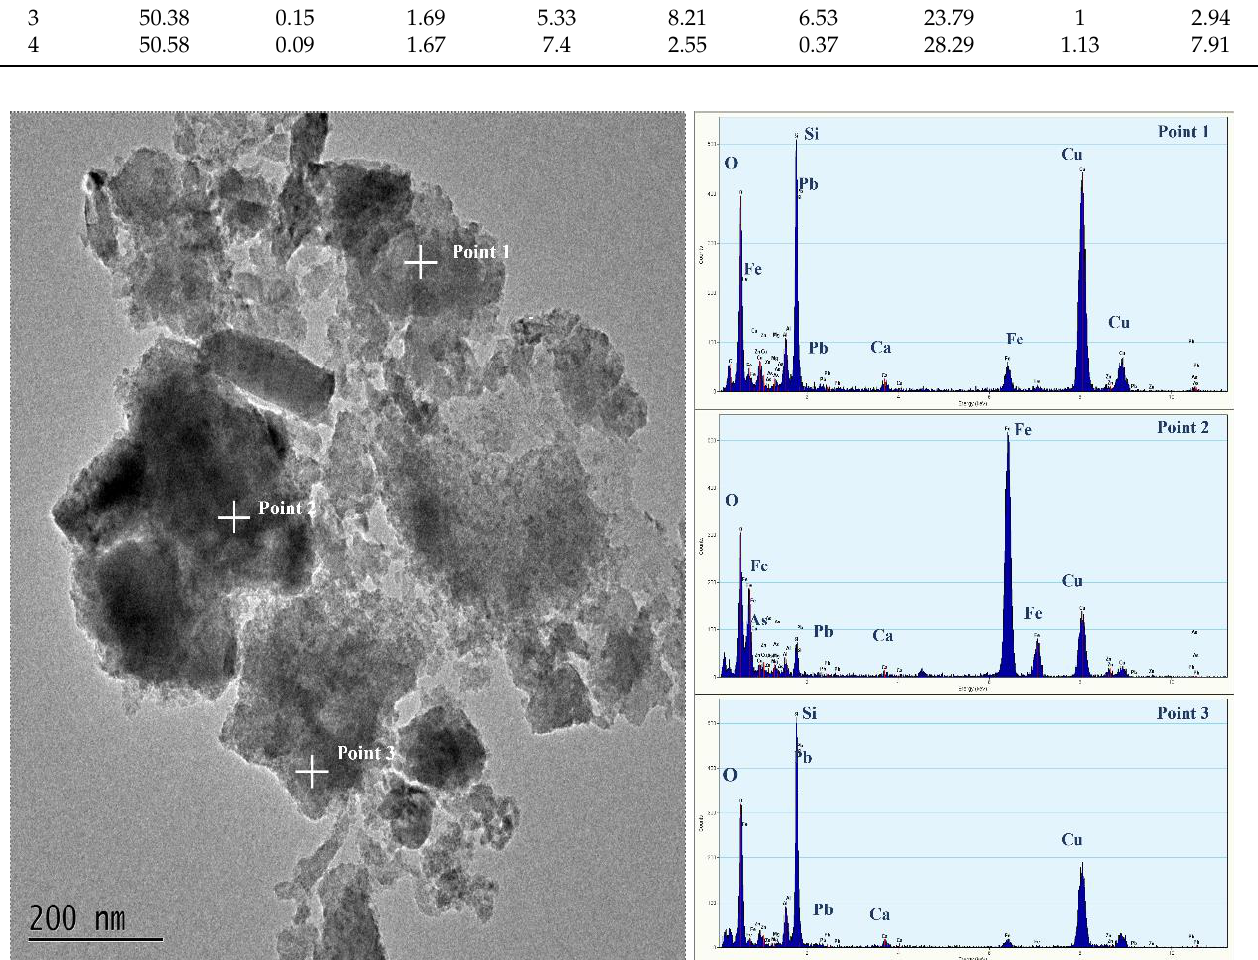
Figure 11. TEM-EDS images of arsenic-bearing precipitate obtained after reaction times of 12 h at a 1:10 solid – liquid ratio, an H 2 O 2 volume ratio of 10%, and a reaction temperature of 25 ◦C.